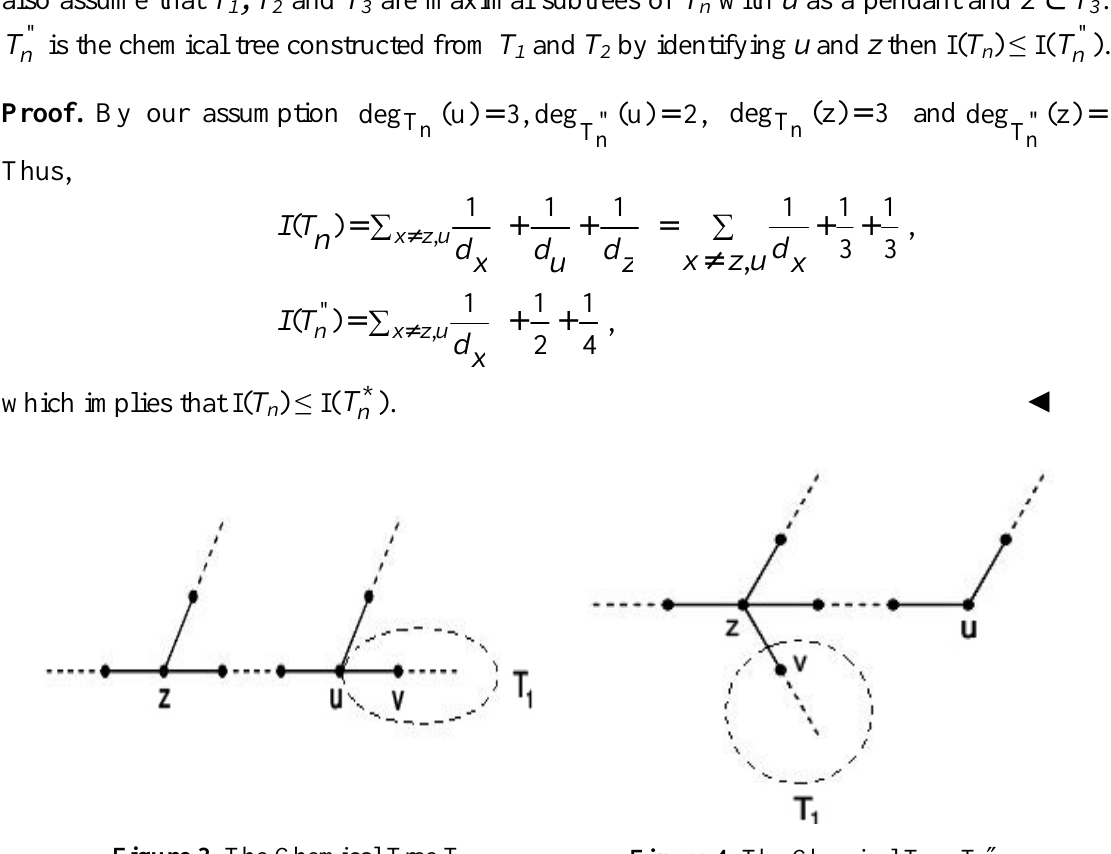
Figure 3. The Chemical Tree T